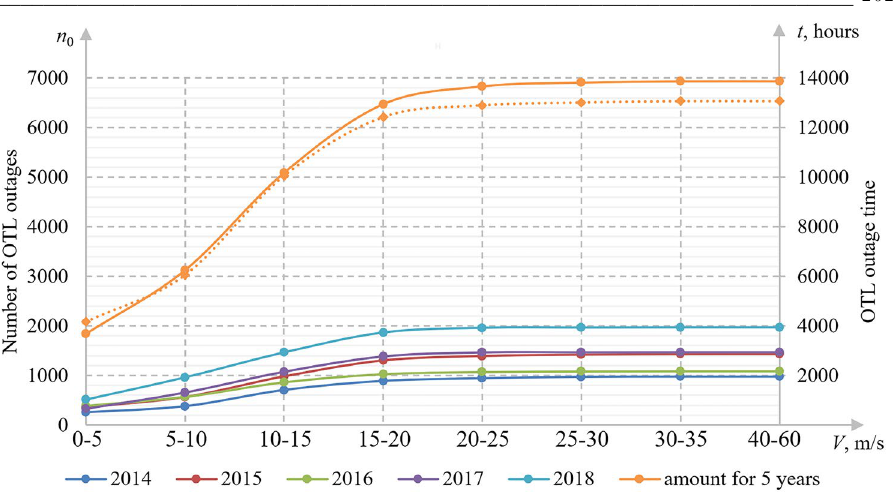
Fig. 4 Dependence of OTL outages number (solid line) under the wind impact at different speeds from 2014 to 2018 and OTL outage time in these incidents (dotted line) over the five years. As can be seen from Fig. 4, the slope of the curves for all cases (from 2014 to 2018)